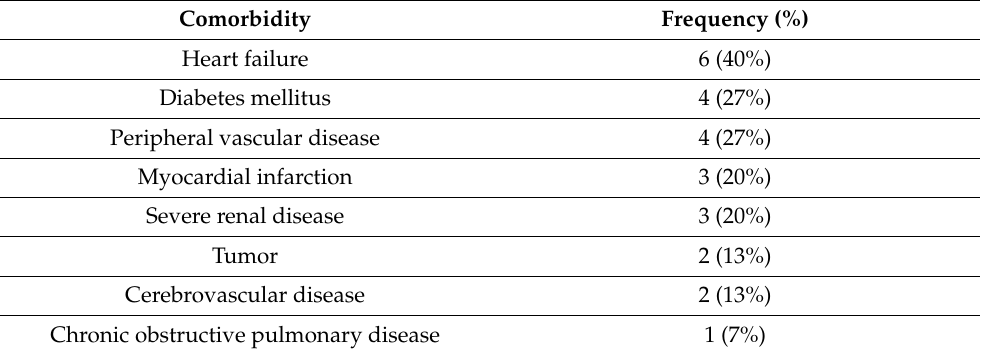
Table 3. Clinical conditions for calculating the age-adjusted Charlson Comorbidity